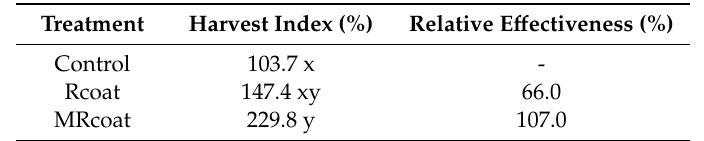
Table 3. Crude protein, fat, crude fiber and ash content of chickpea grains in different inoculation treatments (control, Rhizophagus irregularis (Rcoat), mixture of R. irregularis isolates (MRcoat)) under greenhouse and field conditions.